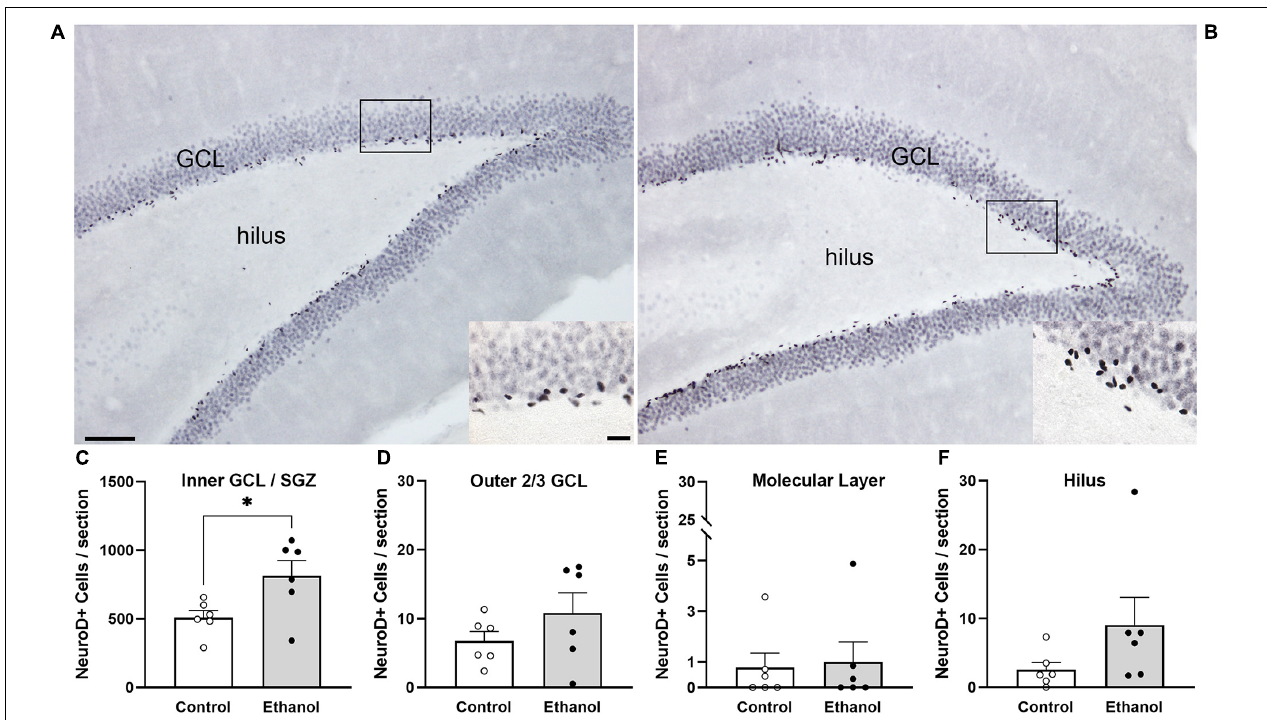
FIGURE 4 | NeuroD1 expression is increased in neurogenic regions in ethanol-treated rats following 14 days of abstinence. Representative images of NeuroD1 immunoreactivity in a control [ (A) n = 6] and an ethanol-exposed [ (B) n = 6] rat at T14. Expression of NeuroD1 was increased in the SGZ and inner third of the GCL (C) , but not the outer 2/3 (D) , molecular layer (E) , or hilus (F) . Bars represent means ± SEM. Symbols represent individual data points. Scale bars = 100 µ m; 20 µ m inset. * p <